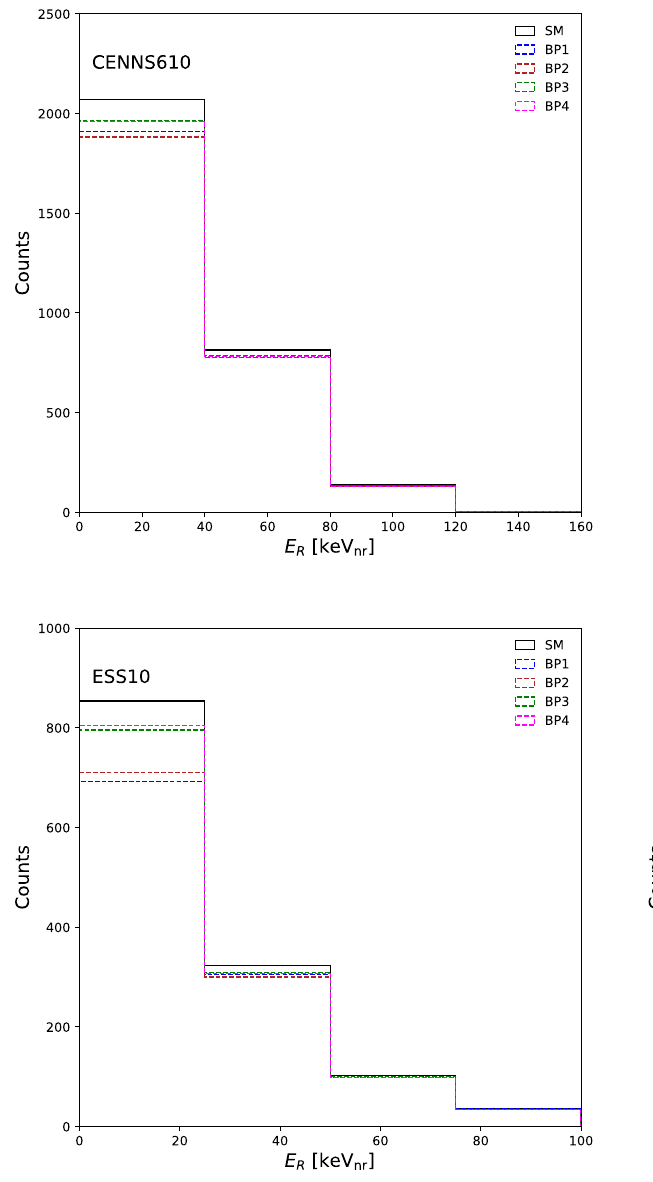
only considered the events above a given energy threshold, whereas for CENNS610 we have used the efficiency of its predecessor